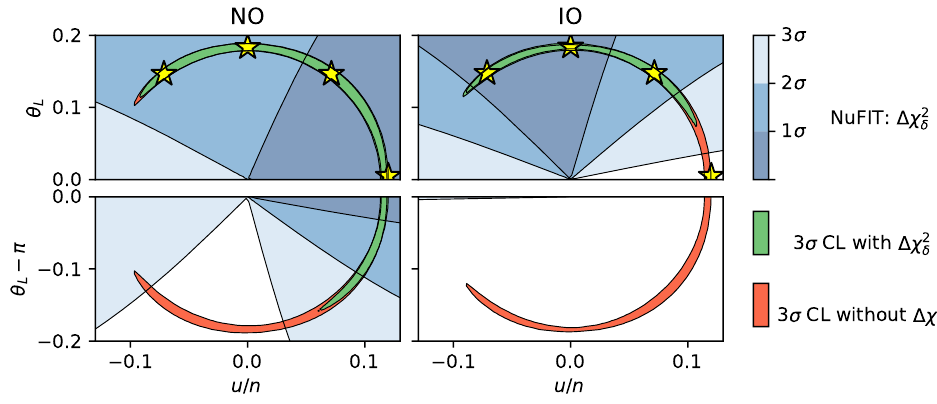
Figure 1 . Case 2) Impact of constraints on the value of the CP phase δ for light neutrino masses with NO (left plot) and IO (right plot), respectively. We show the areas, leading to an agreement with the global fit data at the 3 σ level or better, in the u/n − θ -plane. The orange area corresponds L to the case in which only the information on the three lepton mixing angles is taken into account. In different shades of blue we display the range of the CP phase δ at the 1 σ (dark blue), 2 σ (blue) and 3 σ (light blue) level, as preferred by the global fit data. As one can see, this constraint disfavours certain areas in the u/n − θ -plane. When combining it with the information on the lepton mixing L angles, the green area results as favoured at the 3 σ level. The constraints on the CP phase δ have a moderate impact for light neutrino masses with NO, but substantially reduce the favoured areas in the case of IO. The specific choices n = 14 , u = 0 and u = ± 1 and their corresponding values of θ L for θ small are indicated by yellow stars. Furthermore, we highlight the choice u/n = 0 . 12 and L θ L = 0 with a yellow